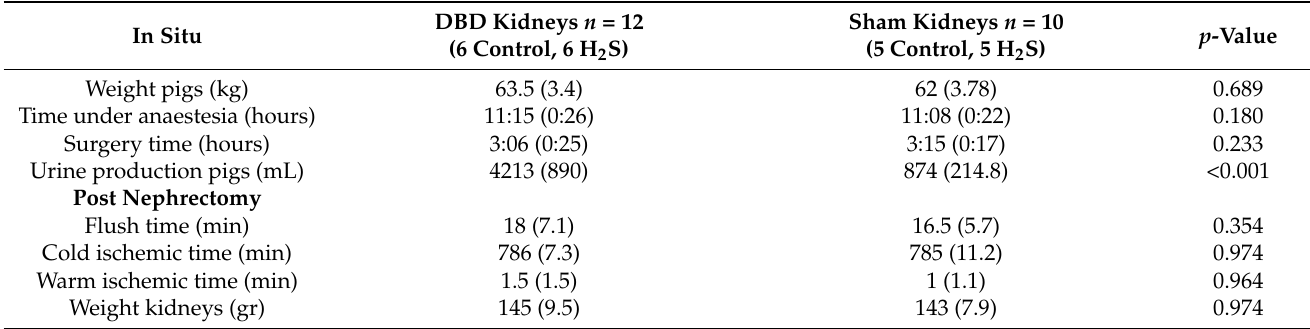
Table 2. Overview of the characteristics of the